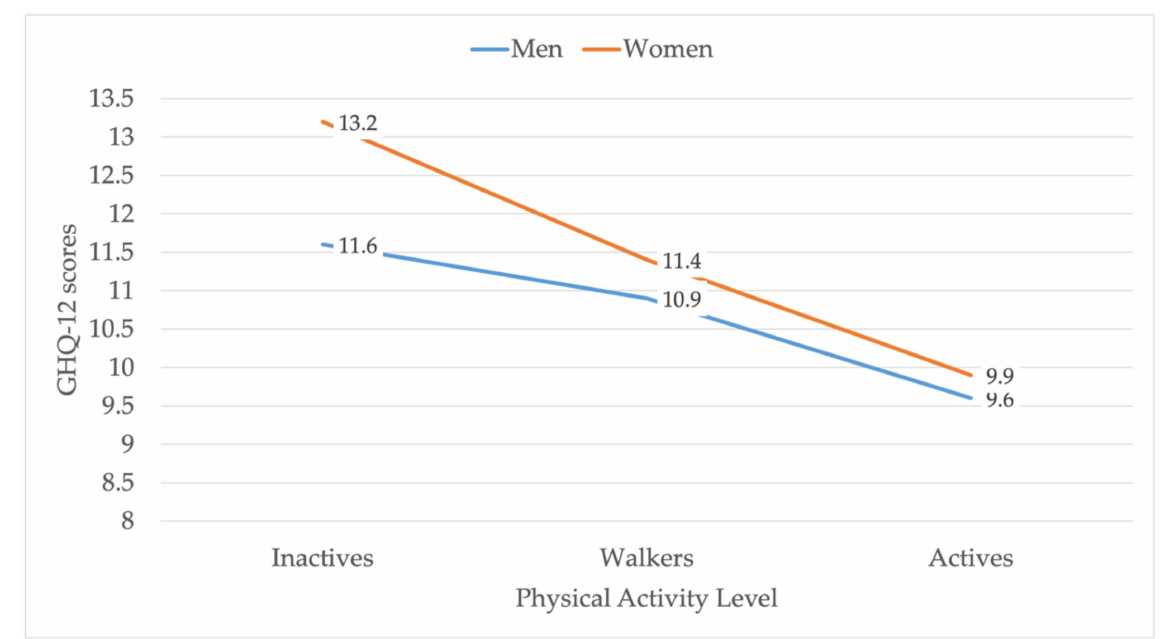
Figure 3. Comparison of mean mental health scores according to physical activity level, differentiated by sex (men and women). GHQ-12: Goldberg General Health